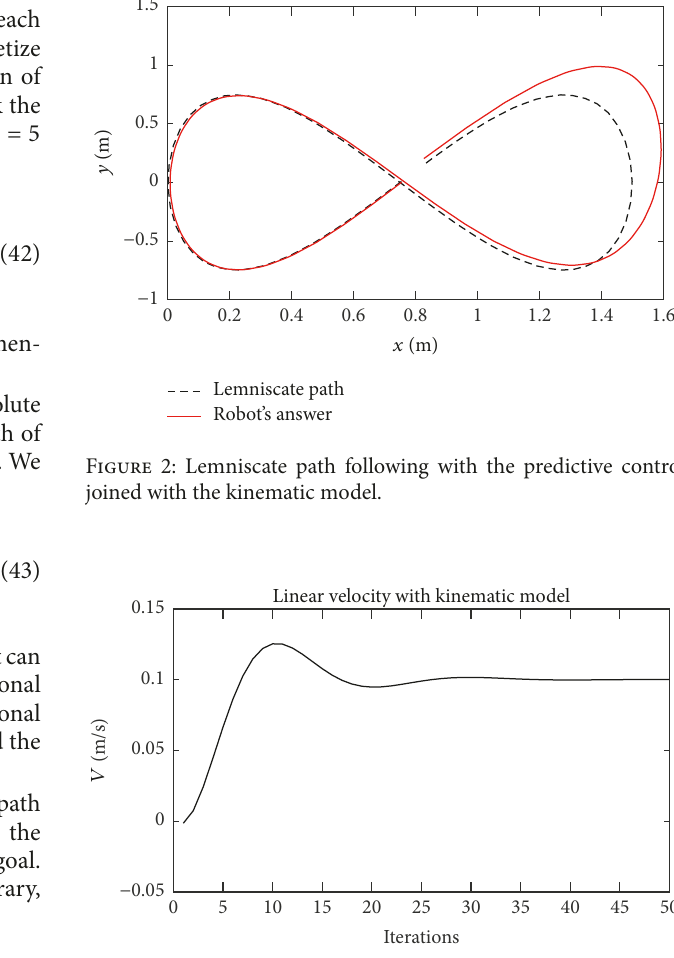
Figure 3: Linear velocity of the kinematic predictive